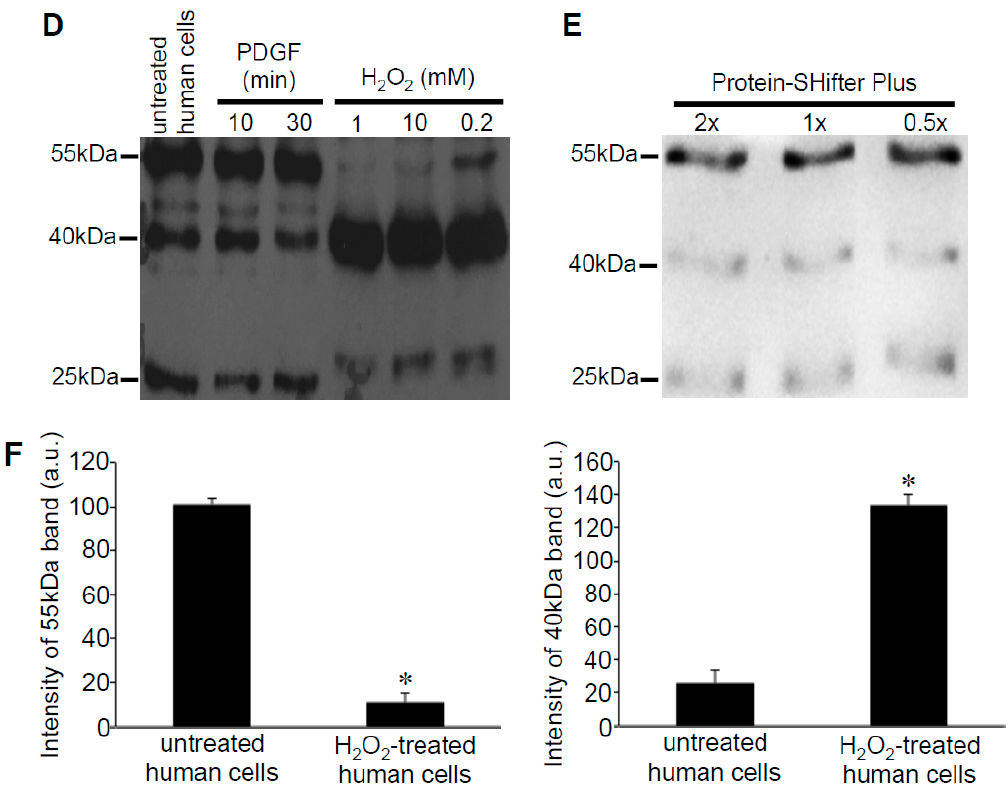
Figure 2. Effects of H 2 O 2 on thiol state of Prx6 in human cells monitored using Protein-SHifter Plus. ( A ) The principle of the - SulfoBiotics - Protein Redox State Monitoring Kit Plus. A free protein thiol group was labeled with the Protein-SHifter Plus that contained maleimide with a high affinity toward reduced cysteine. After electrophoresis, the large Protein-SHifter Plus moiety was eliminated with UV light, increasing the efficiency of Western blotting and allowing for the detection of specific proteins in the biological samples. ( B ) Amino acid sequence of human Prx6. Cys47 indicated in red is conserved catalytic cysteine, while Cys91 indicated in blue is non-conserved cysteine. ( C ) Schematics of the human Prx6 structure with or without Protein-SHifter Plus attached. SOx indicates oxidized cysteine that would not bind to the Protein-SHifter Plus. ( D ) Human pulmonary artery smooth muscle cells were treated with or without PDGF (10 ng/mL) or H 2 O 2 at indicated concentrations for 15 min. Cell lysates were prepared, incubated with Protein-SHifter Plus, subjected to SDS-PAGE without BME, and immunoblotted with the Prx6 antibody. ( E ) Untreated cell lysates were incubated with different amounts of Protein-SHifter Plus with 1x being the amount used in all experiments in this study. ( F ) Bar graphs represent the means ± SEM of the intensities of 55- and 40-kDa bands in arbitrary unit (a.u.) ( n = 5). The symbol * represents the value significantly different from the untreated control value at p < 0.05.